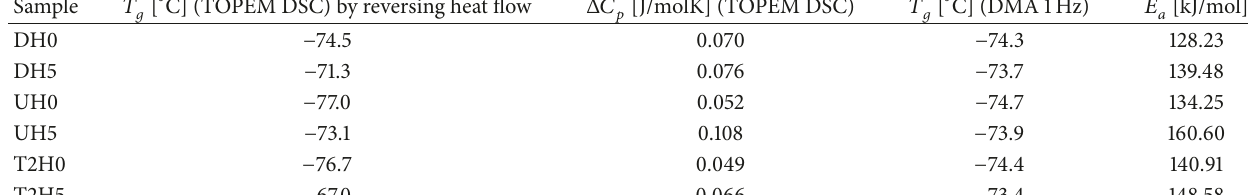
Table 2: Glass temperature, Δ𝐶 𝑝 , and activation energy of glass transition for POM and POM/HAp nanocomposites. Sample